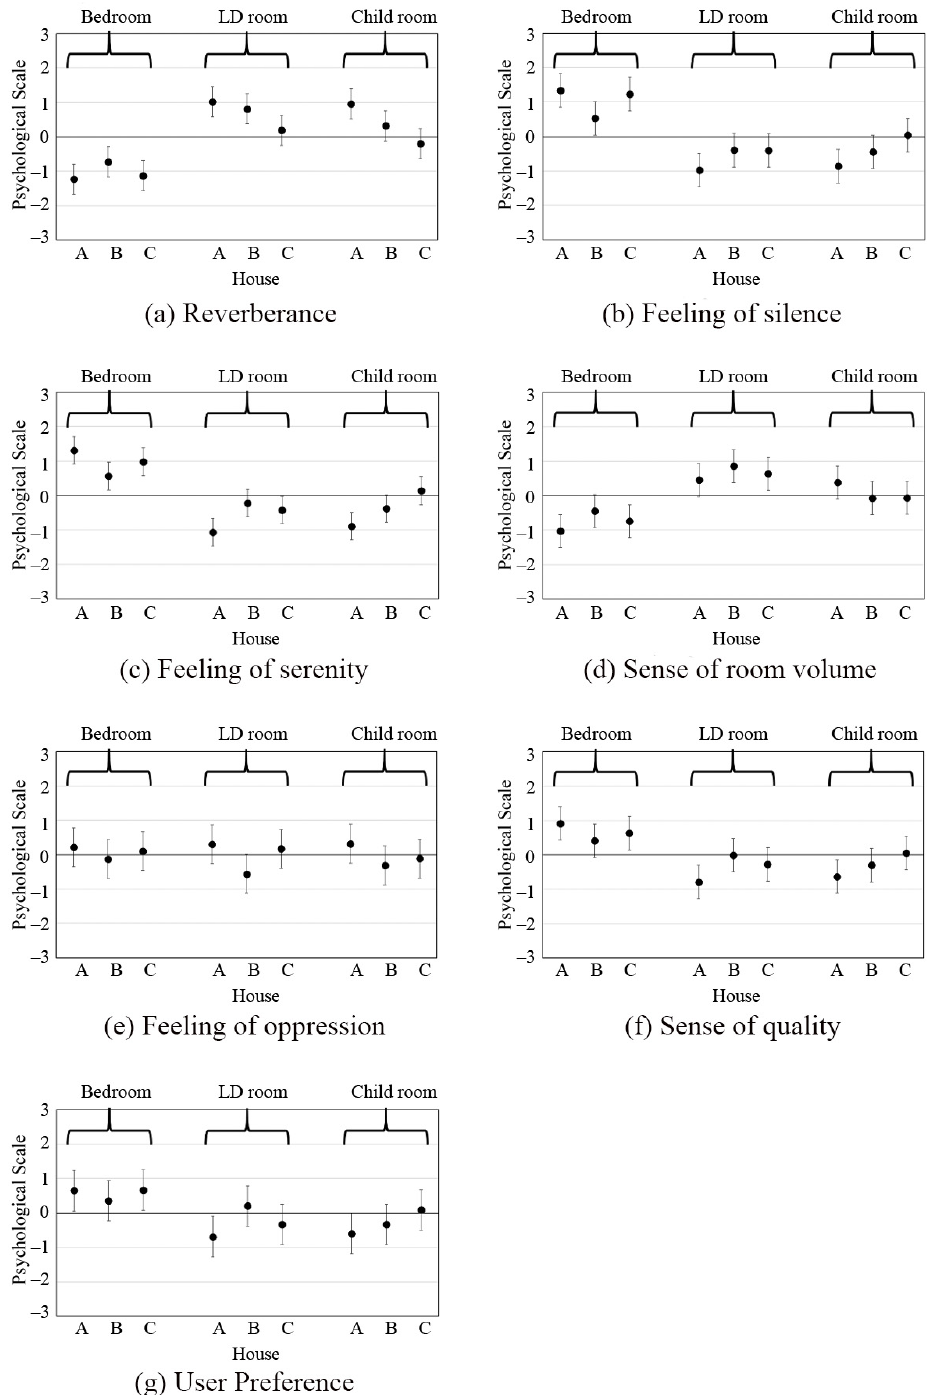
Figure 14. Results of the psychological experiments in the nine rooms using recording sources and headphone listening. These seven figures show the psychological values of the nine rooms for each subjective item. The error bars represent the 5% significant yardsticks.